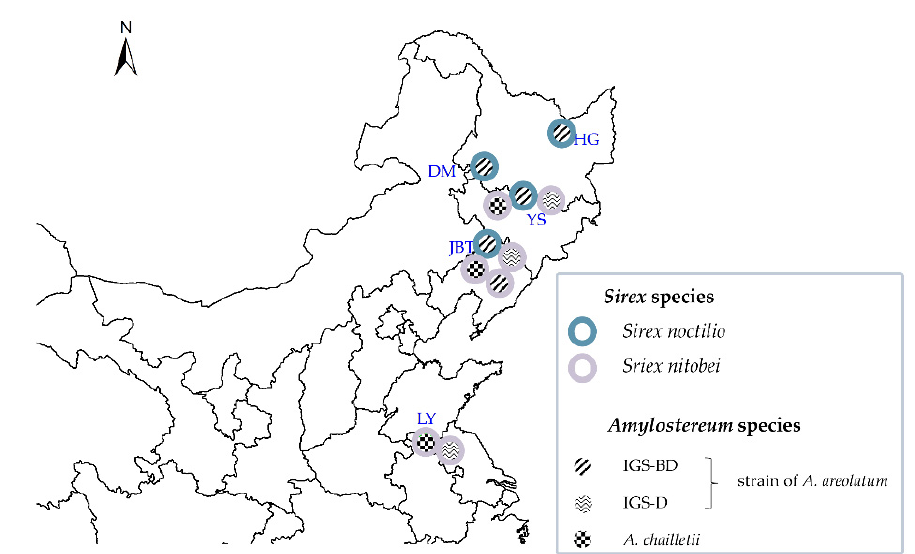
Figure 5. Distribution of the associations between Sirex species and Amylostereum species (strains) in China. Table 4. Species and IGS strains of Amylostereum associated with Sirex noctilio and Sirex nitobei in the current study.